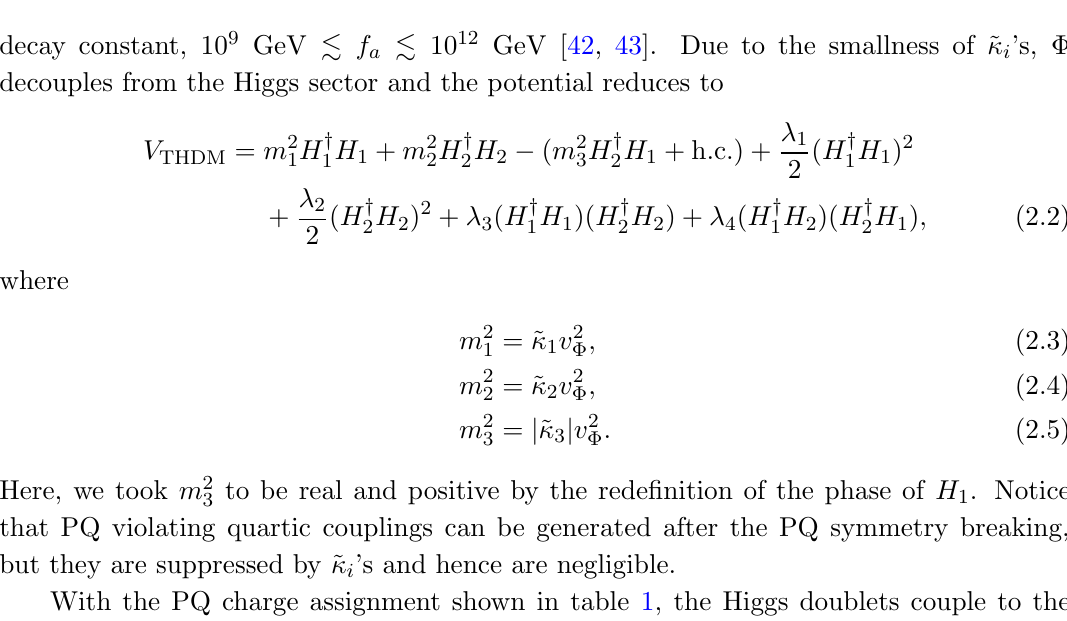
Table 1 . Assignment of the PQ charge in the DFSZ axion